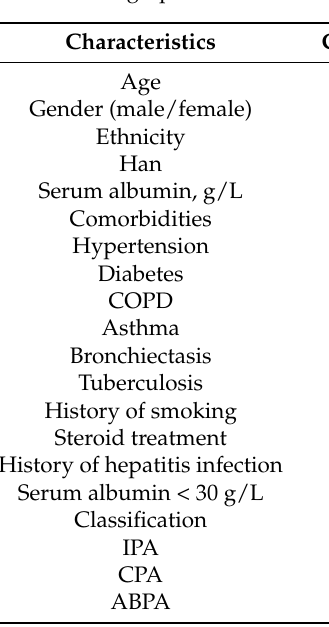
Table 1. Demographic and clinical characteristics of the study